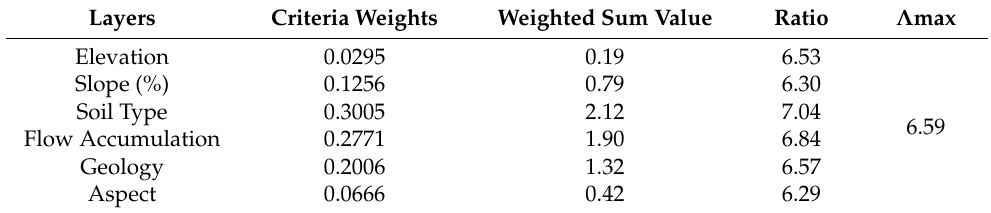
Table 4. Weight of criteria for road location.